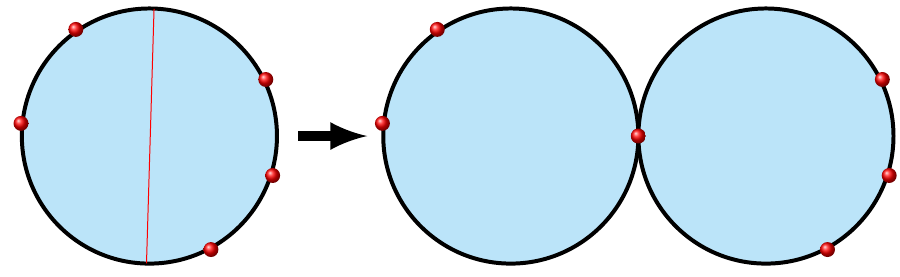
Figure 4 . Contraction of a geodesic arc produce two nodal